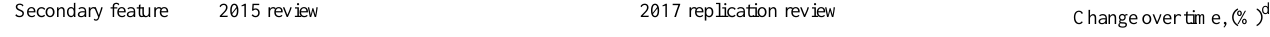
Table 5. Secondary selection feature summary of the evaluated communication apps (cApps; note: as the percentages were rounded, some categories may not add up to